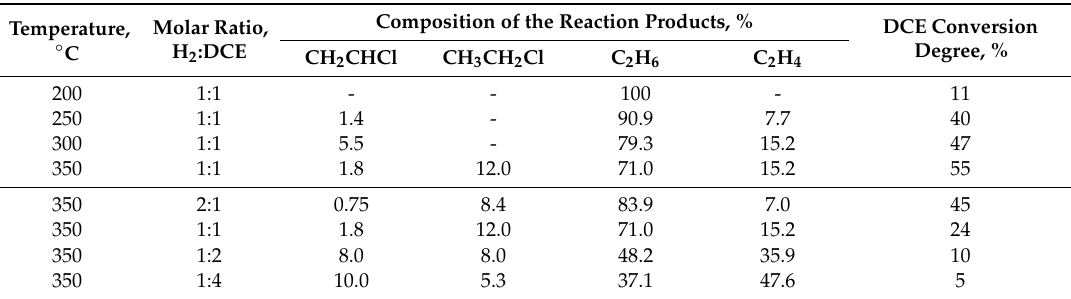
Table 6. Influence of temperature and reagents ratio on composition of 1,2-dichloroethane hydrodechlorination products. Residence time: 18 s.